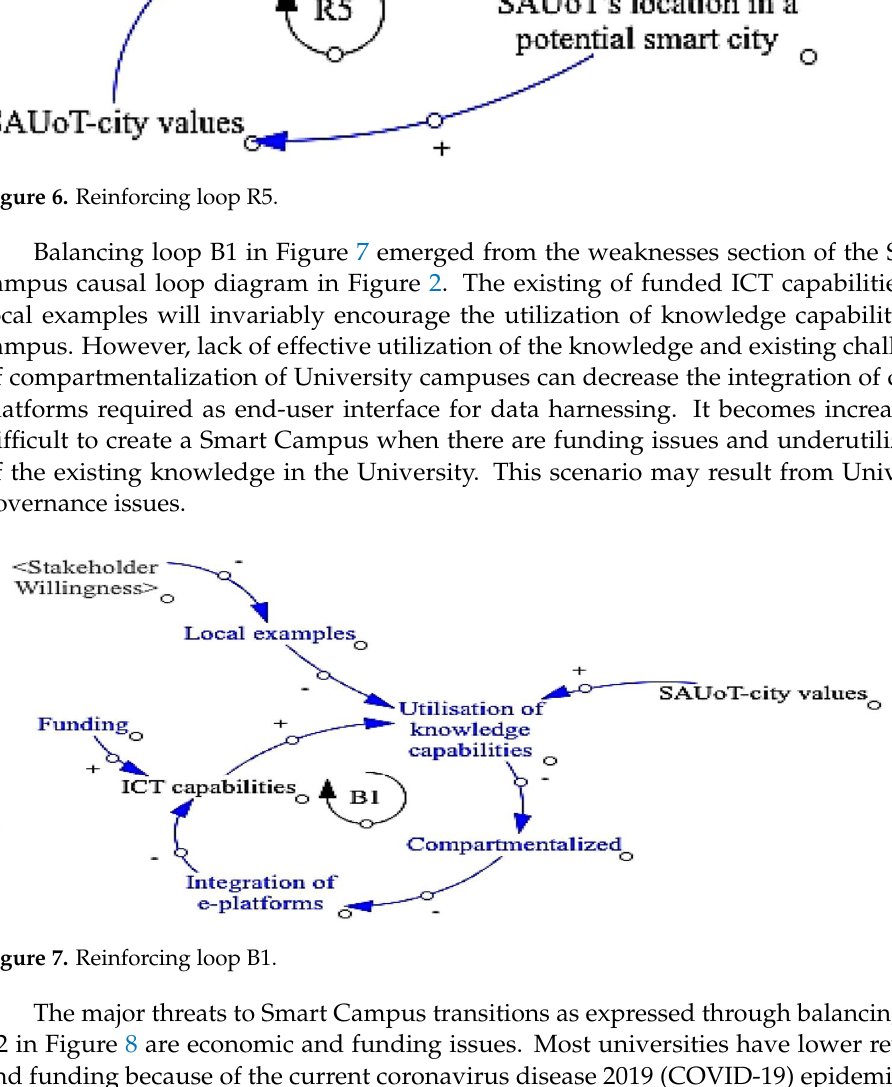
Figure 7. Reinforcing loop B1.